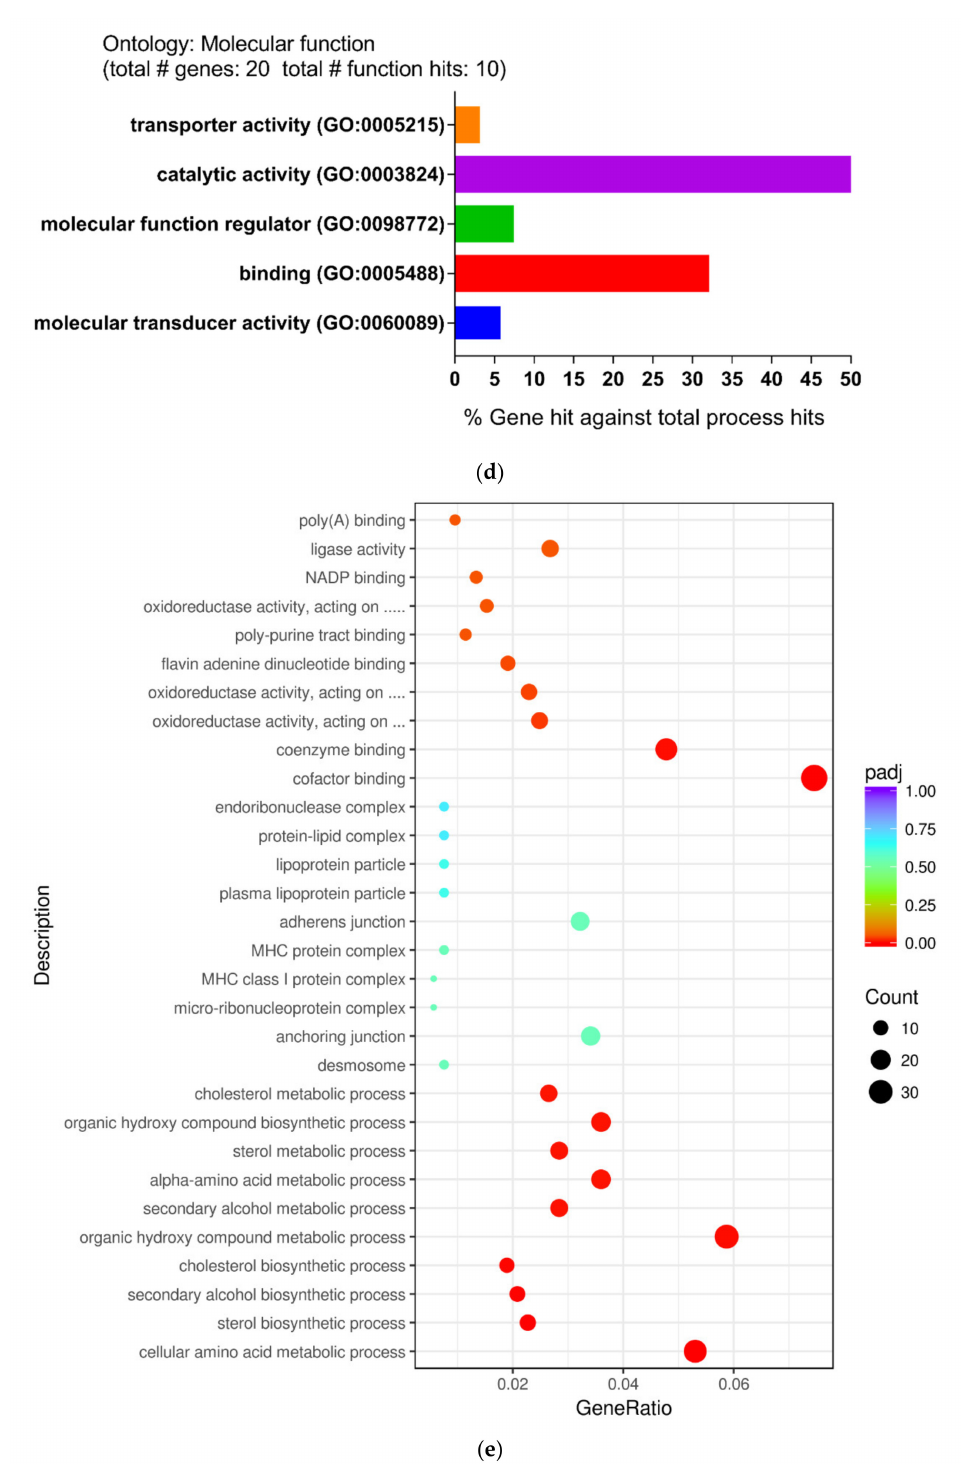
Figure 2. Functional and pathway enrichment analysis of identified modules associated with di ff erentially expressed genes (DEGs). The DEGs were subjected to Gene Ontology (GO) classification using the PANTHER (Protein ANalysis THrough Evolutionary Relationships) GO classification system. ( a ) Bar graph of enriched terms of the genes (colored by p -values). ( b ) Biological process (BP). ( c ) Cellular component (CC). ( d ) Molecular function (MF). ( e ) Network maps of GO terms (GO dot). The abscissa is the ratio of the number of di ff erentially expressed genes, which annotates the GO term to the total number of di ff erentially expressed